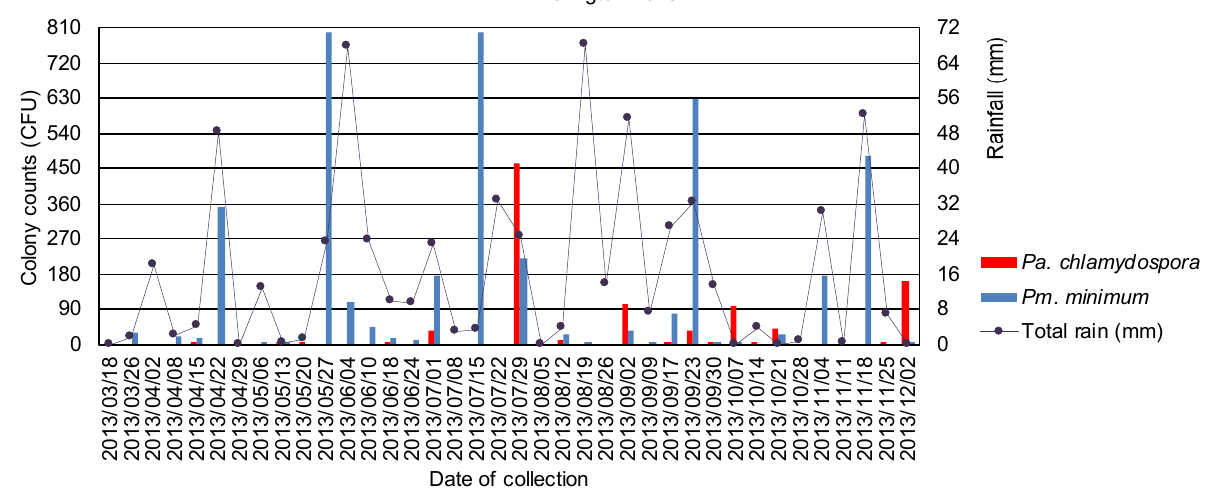
Figure 16. Phaeomoniella and Phaeoacremonium spp. cfu cultured from five vaseline coated microscope slides affixed to each of five root- stock mother vines in a rootstock mother block in Wellington, Western Cape province in 2013. The slides were replaced weekly. Each bar represents the total number of cfu cultured on three Petri dishes.